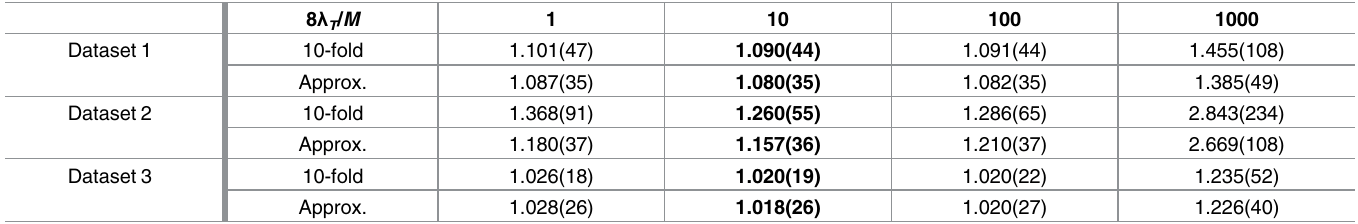
Table 1. CVE values determined by 10-fold CV and our approximation formula against λ T . λ ℓ mon to all cases). The number in brackets denotes the error bar to the last digits. The optimalvalues are bolded.The tuning constants δ and θ are set to be δ = 10 − 4 and θ = 10 − 12 , respectively.